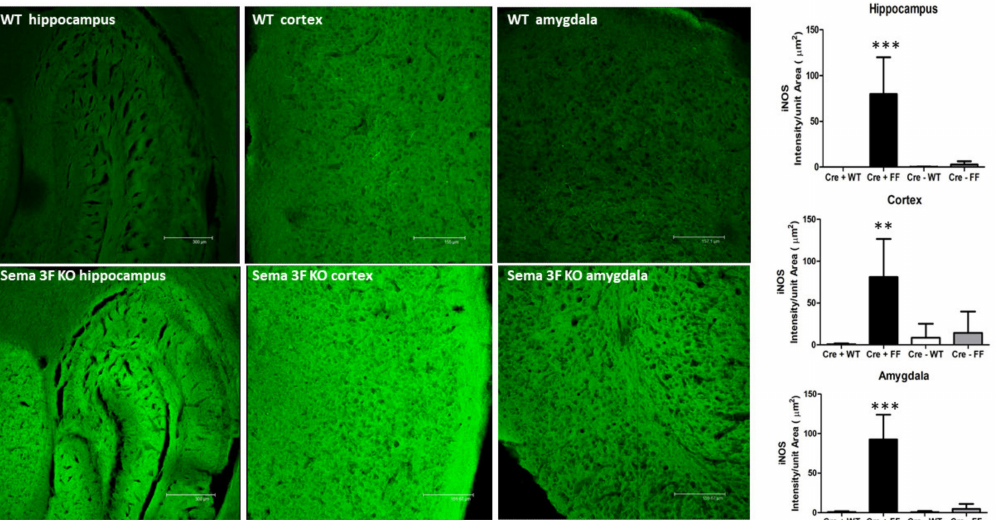
Figure 6. iNOS Expression in Sema 3F KO Mice . Left panel: iNOS immunofluorescence in hip- pocampus, cortex, and amygdala of Sema 3F KO mice and their wild type (WT) littermate showed significantly increased iNOS expression in Sema 3F KO tissue. Right panel: quantification of iNOS immunofluorescence showed significantly higher fluorescence/unit area in the hippocampus, cortex, and amygdala of Sema 3F KO mice compared to all three control mice; *** p ≤ 0.0001; ** p ≤ 0.001; n = 5.